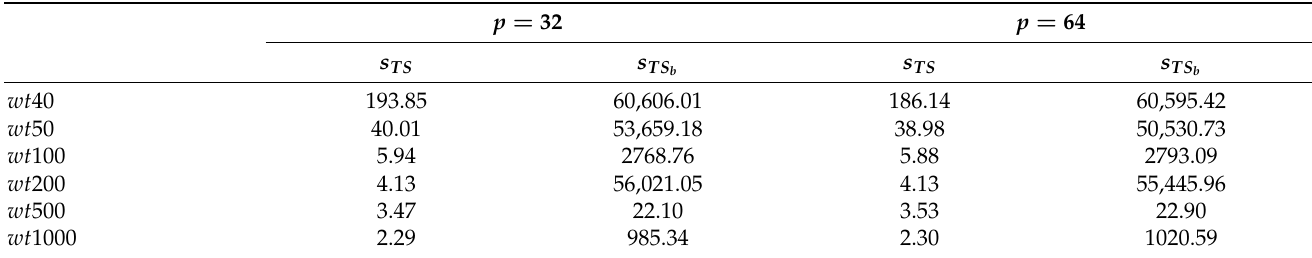
Table 5. Speedup values for parallel tabu search